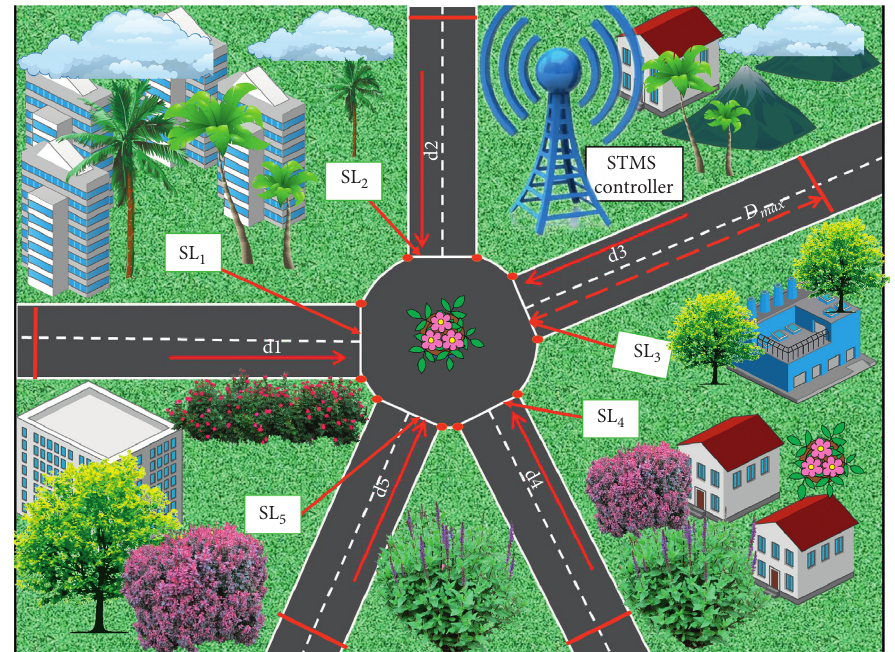
Figure 7: The smart traffic management system (STMS) is placed in the intersection. STMS must be programmed by the heading angle (denoted by d1, d2, . .. ,d5) of each road in the interaction. Vehicles to be considered in the optimization algorithm are those currently between the stop line (SLi, i � 1, 2, .. . 5) and D : away from the max